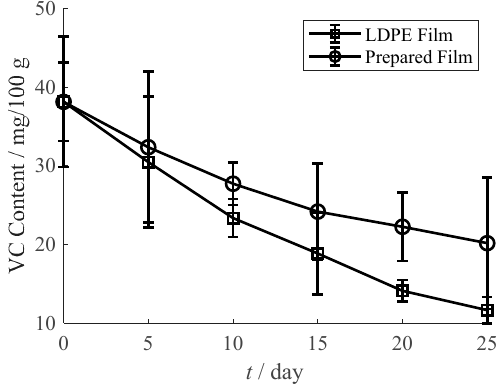
Figure 12. VC content of orange juice in LDPE film pouch and prepared film pouch.